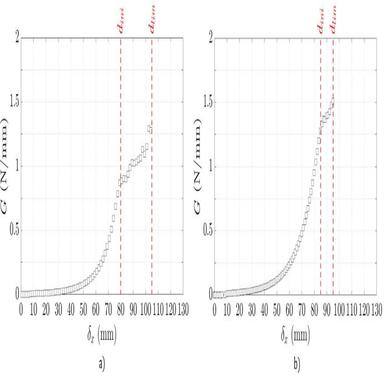
ERR-displacement curves for (a) rigid (T4-01) and (b) flexible (T5-01) adhesive samples, tested following the WDT+ method. For the sake of clarity, 1 of every 1000 points is represented.